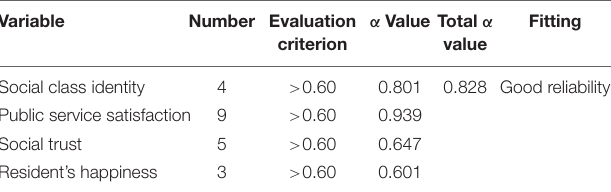
TABLE 1 | Reliability analysis of